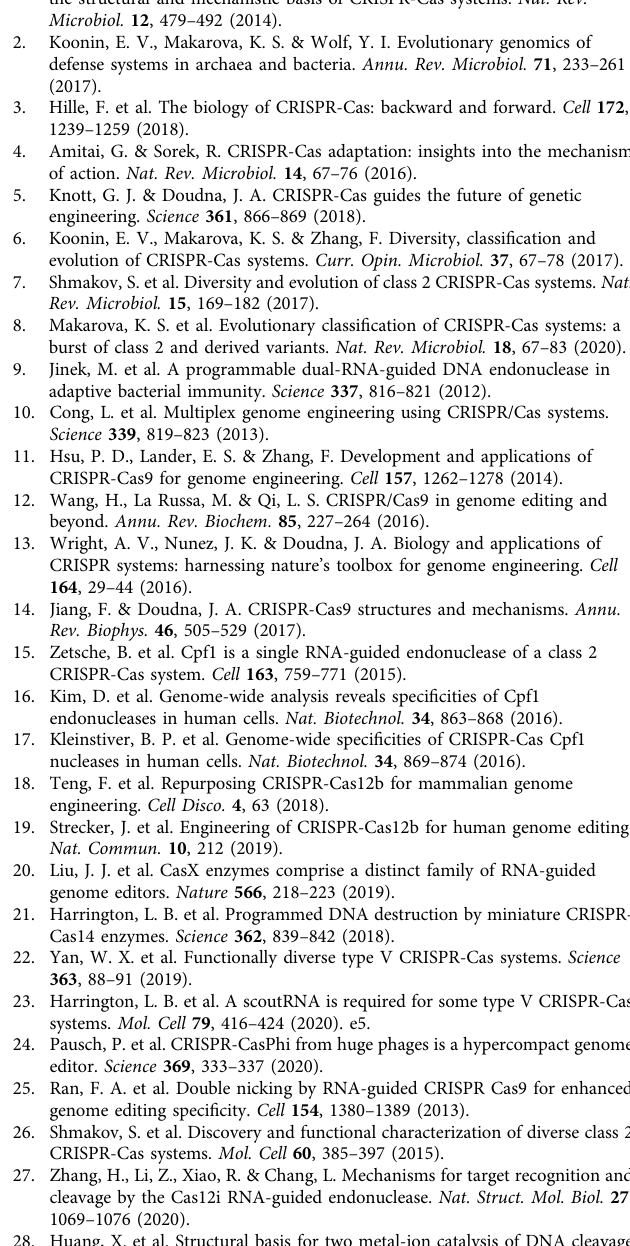
Plasmid cleavage assay . Synthetic oligonucleotides (Supplementary Table 5) encoding two strands of target DNA duplex were annealed and inserted between EcoRI and HindIII sites of the pUC-19 vector. Plasmids were veri fi ed by DNA sequencing and further linearized by ScaI. Reaction mixtures were prepared by incubating Cas12i1 ( fi nal concentration of 0.33 μ M) with crRNA ( fi nal con- centration of 0.33 μ M) to form the binary complex at 25 °C for 30min in assay buffer (50 mM Tris-HCl (pH 8.0), 150mM NaCl, 10mM MgCl 2 , 1mM DTT). The cleavage assays were then carried out by adding 1000ng pUC-19 target plasmids at